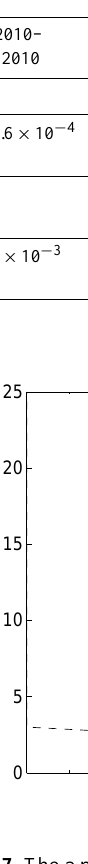
Fig. 7. The a priori state vector (solid line) with its uncertainties σ a (dashed